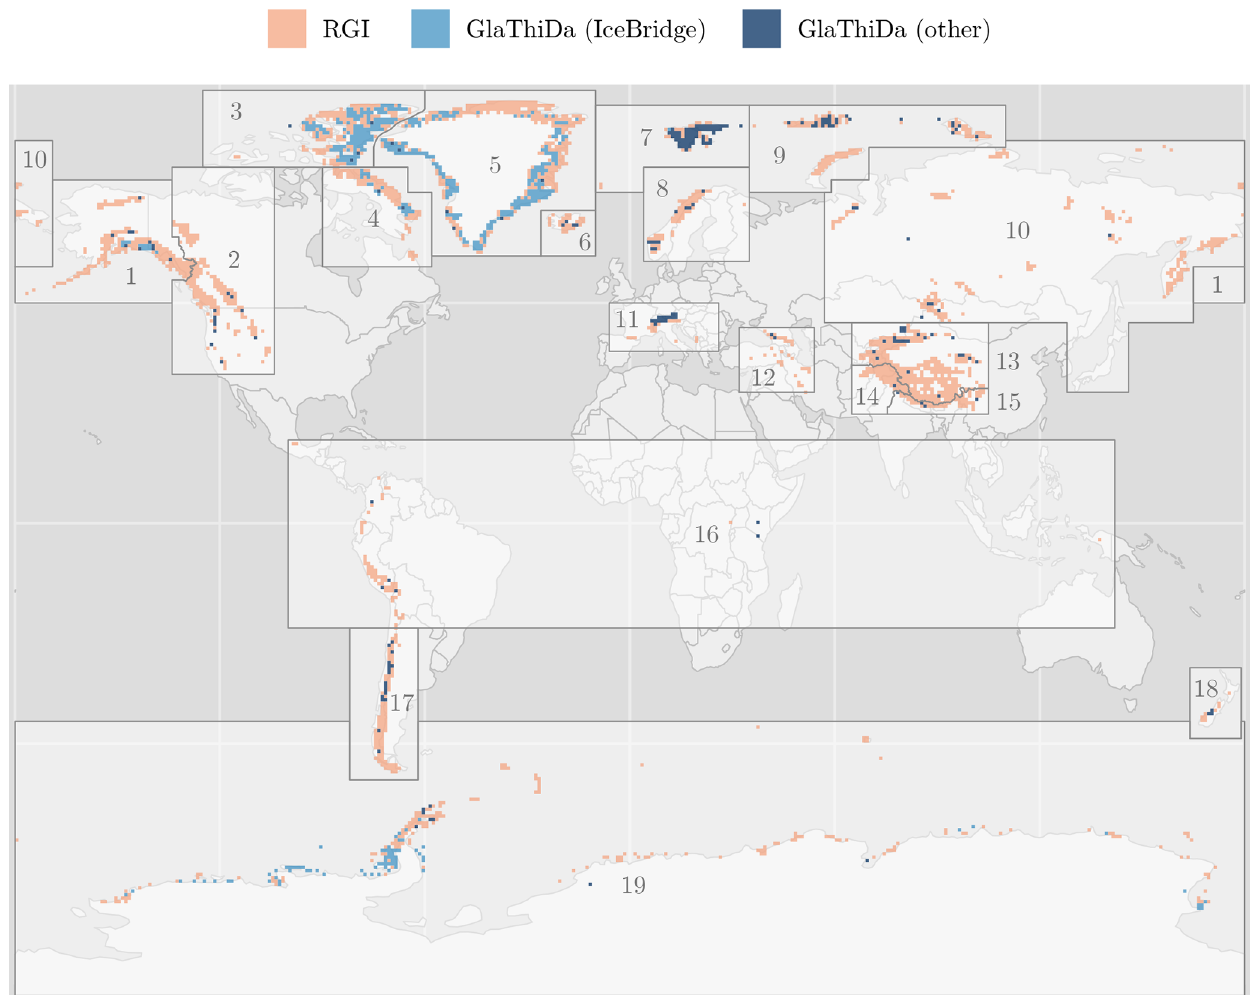
Figure 7. Map comparing GlaThiDa coverage to global glacier coverage according to the Randolph Glacier Inventory (RGI 6.0). Each grid cell represents 78 . 7km × 78 . 7km (roughly 1 ◦ × 1 ◦ ) in a cylindrical equal-area map projection. Light blue cells contain GlaThiDa data from IceBridge, while the overlaying dark blue pixels contain GlaThiDa data from other sources. Numbered grey polygons correspond to the glacier regions (GTN-G, 2017) listed in Table 3. Made with Natural Earth country polygons (https://www.naturalearthdata.com, last